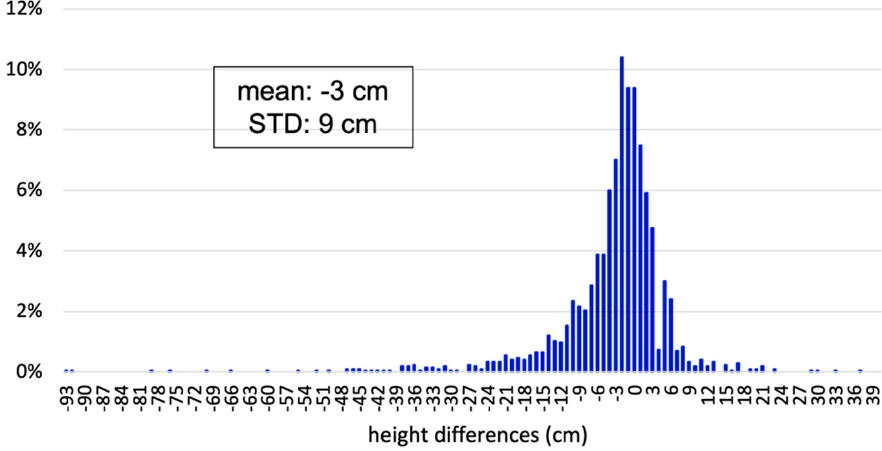
Figure 3. Histogram distribution of the height differences (GNSS-UAV) expressed in cm. Four height profiles defined using both GNSS and UAV are shown in Figure 4. Three profiles (a, b, d) are related to cross-shore transects, and one (c) is related to the along-shore transect. Results are generally consistent at a few cm level and differences rising up to 30 cm are present in the cross-shore profile (a) where it goes through a bush area. The worst case is represented in Figure 4d, where a regular bias in the dm order seems to affect the GNSS and UAV